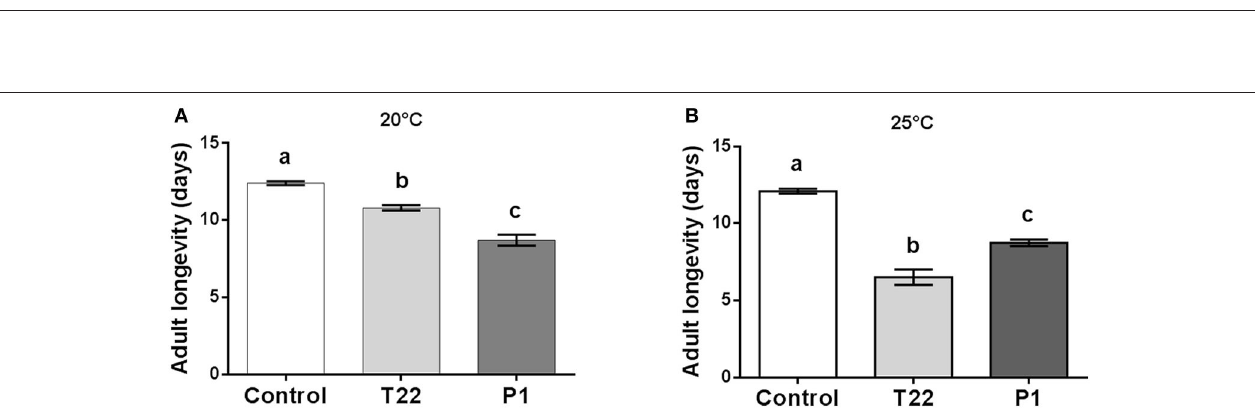
FIGURE 3 | Spodoptera littoralis larvae survival when fed leaves from tomato plants inoculated with Trichoderma strain T22 or P1 then grown at 20 ◦ C (A) or 25 ◦ C (B) . At 20 ◦ C, (A) survival was significantly lower on T22-tomato with respect to P1- and Control- tomato, whereas, when plants were grown at 25 ◦ C, (B) larvae fed on T22- or P1-tomato showed higher mortality compared to Control. Different letters denote significant differences in the survival curves (Log-Rank test, P < 0.0001).